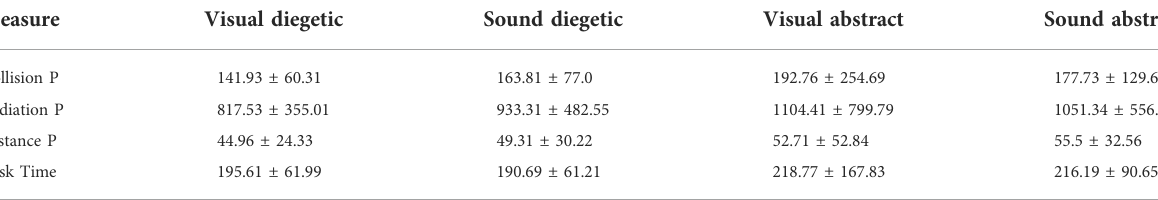
TABLE 10 Task performance data. Each result is reported as M ± SD.